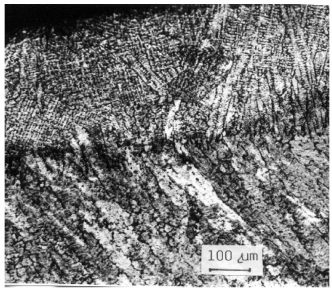
Figure 7. Cast structure of hardfacing weld E 508 B.